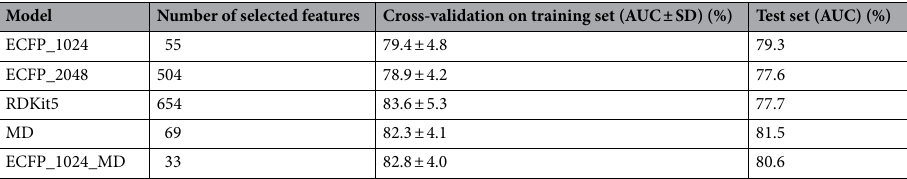
Table 1. Performances on tenfold cross-validation and the test set achieved by each descriptor type; ECFP (1024-bit length), ECFP (2048-bit length), RDKit fingerprints (2048-bit length), molecular descriptors and the combination of ECFP (1024-bit length) with molecular descriptors. The number of features selected by applying variance and mutual information-based methods is